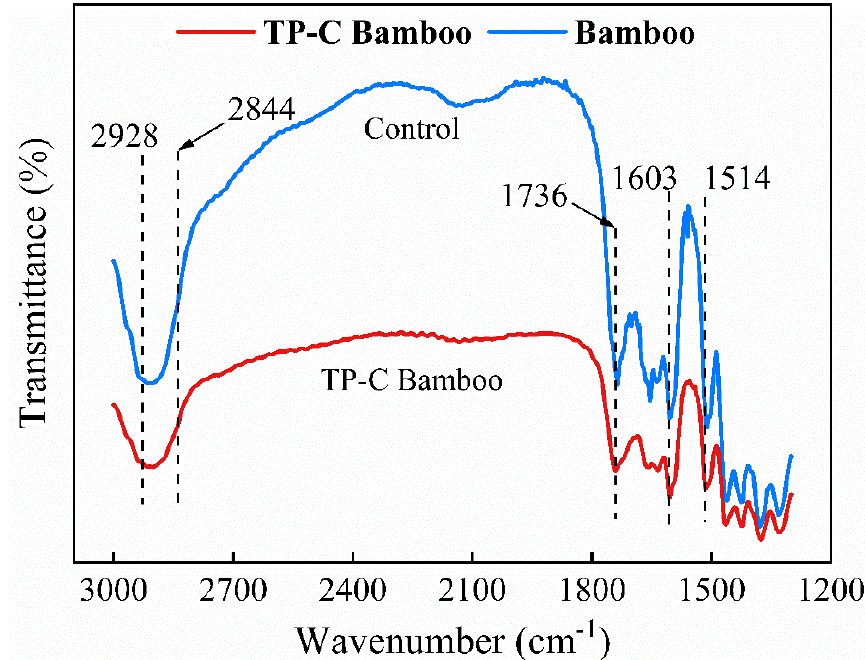
Figure 6. FT–IR infrared spectra of bamboo and antioxidant-modified citral bamboo.